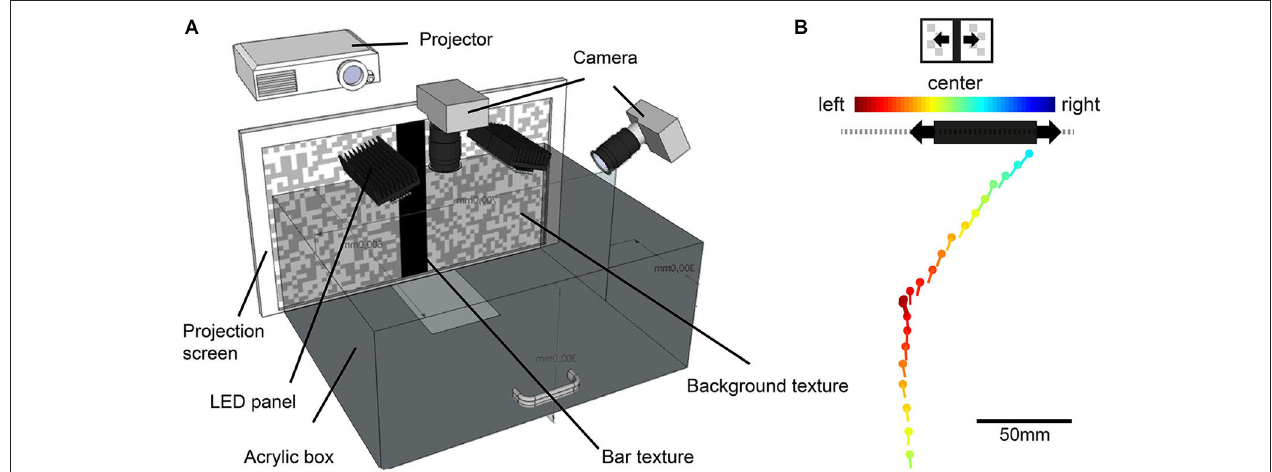
shown for 100 ms intervals. Color code of dot and lines indicates the position of the moving bar’s center. Warm colors indicate a position to the left, cold colors a position to the right of its central position. The black bar position represents the position of the bar at the end of the approach. The gray dashed line illustrates the textured